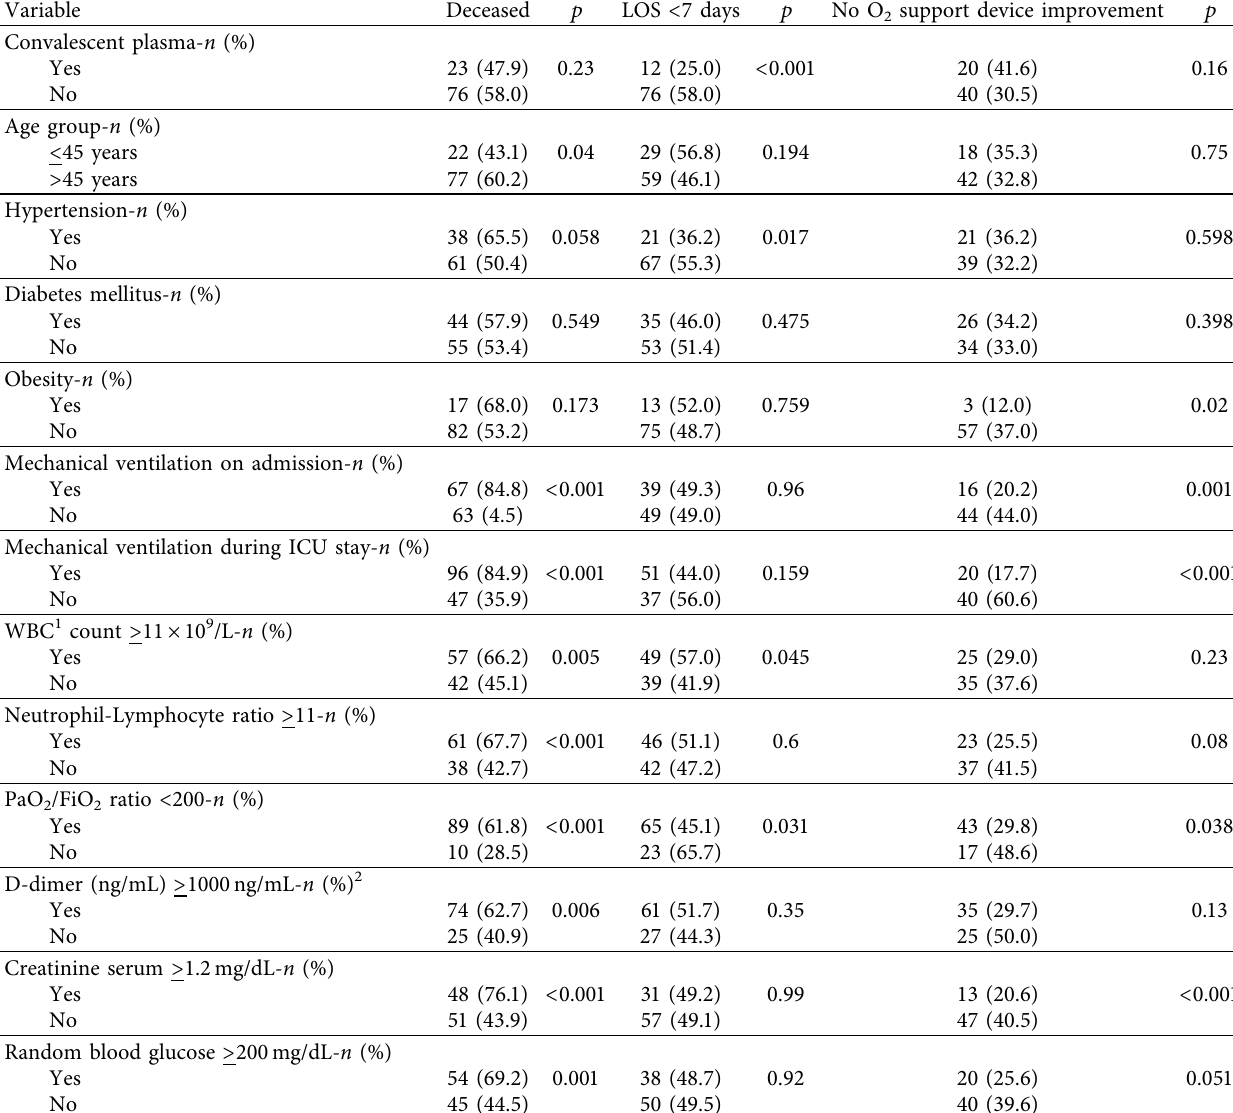
Table 2: Bivariate analysis of